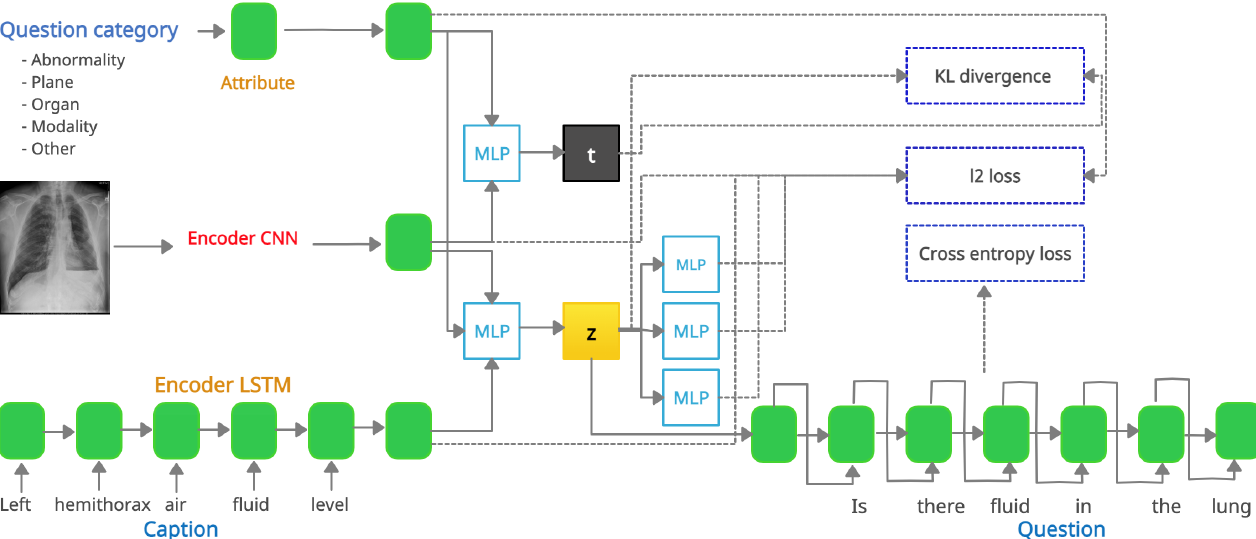
Figure 3. Overview of VQGRaD, a visual question generation system for radiology images. Input captions are encoded by an LSTM. Images are encoded by a CNN. t -space contains images and categories features, whereas z -space includes images, captions, and categories features. Questions can be generated from either the caption latent space z or the category latent space t